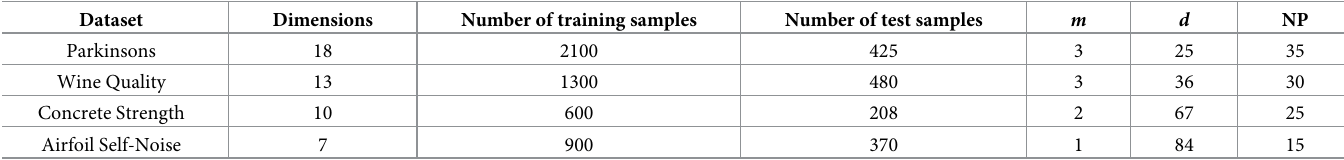
Table 2. Test data and parameters.